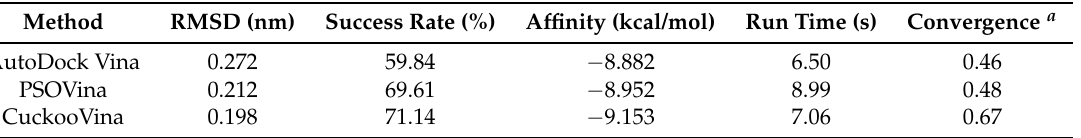
Figure 2. Docking performances of AutoDock Vina, PSOVina, and CuckooVina in 30 independent docking repeats using the Astex Diverse dataset. Each data point is an average of 85 complexes. Table 3. Average performances of AutoDock Vina, PSOVina, and CuckooVina for docking the Astex Diverse